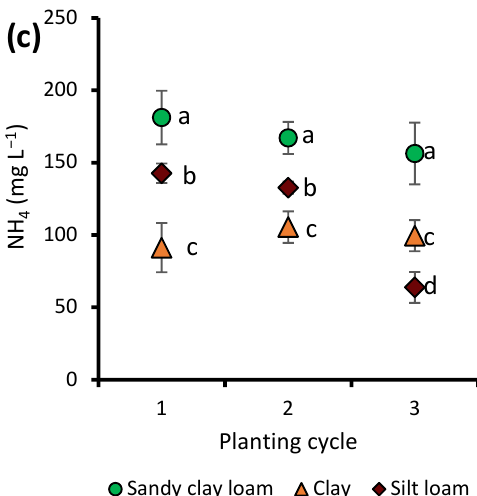
Figure 3. Means ( ± SE) of interaction effect between soil type and planting cycle on ( a ) VMC, ( b ) leachate volume, and ( c ) NH + leachate contents. VMC volumetric moisture content, CL clay soil, SL silt loam soil, SCL sandy clay loam soil. On the same chart, means with the same letters are not significantly different ( p > 0.05) from one another using Tukey’s test. Means were taken across all the treatments.